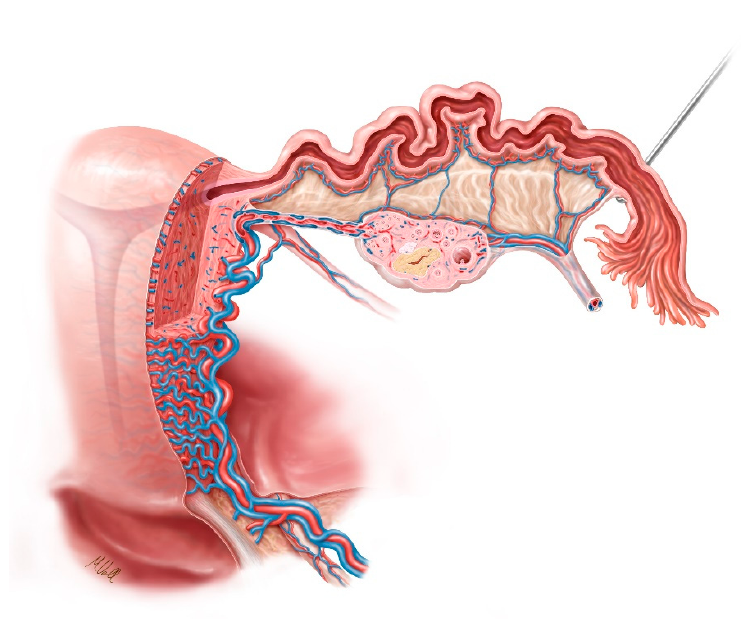
Figure 2. Schematic illustration of the blood flow in the inner female genital organs.